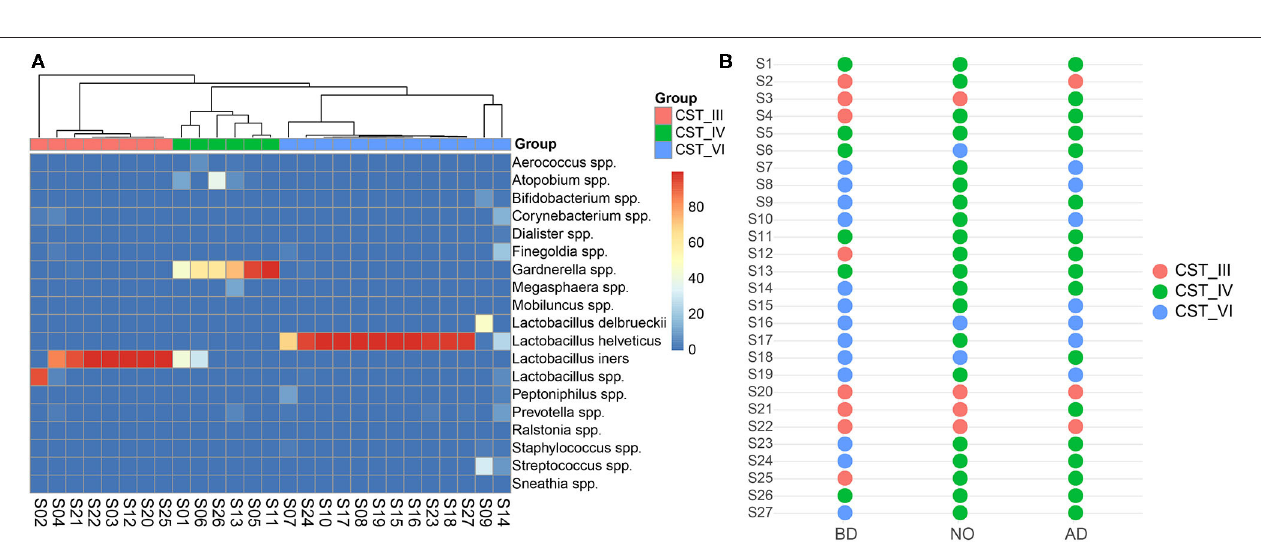
FIGURE 4 | Different microbioal ecological network between before and after delivery with SpiecEasi analysis. (A) Microbial ecological network at the family level in the BD group. (B) Microbial ecological network at the family level in the AD group.